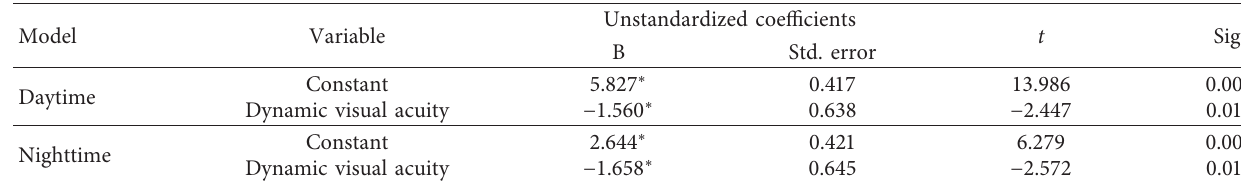
Table 7: Regression models for conflicts using visual